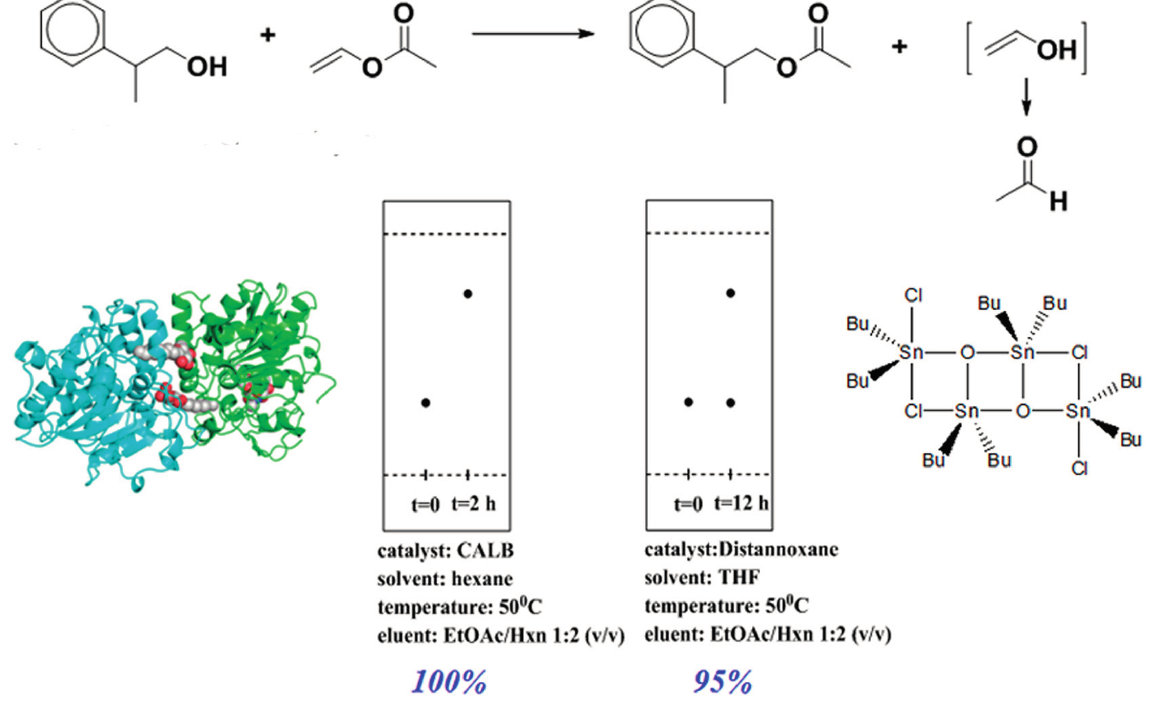
Figure 3. Transesterification of vinyl acetate: comparison of CALB and a tin-based catalyst. Reprinted with permission from [6]. Copyright © 2011